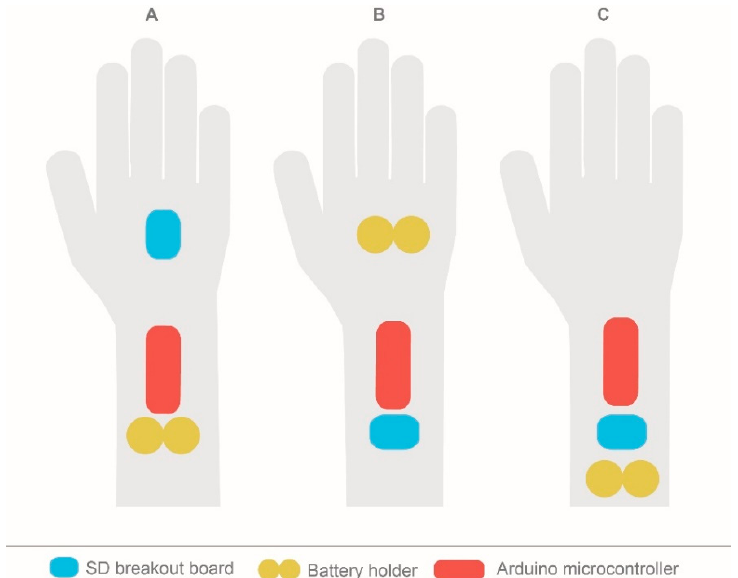
Figure 6. Setup options for the three main components: SD breakout board, battery holder and Arduino microcontroller.